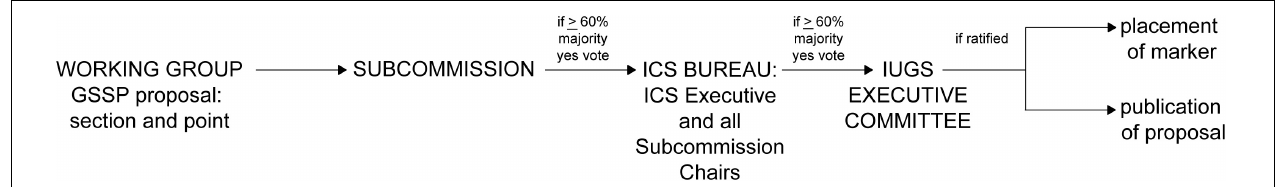
FIGURE 5 | Flow chart showing how the ICS votes on and ratifies a GSSP (redrawn after Finney and Edwards, 2016; used with the permission of the copyright holder, The Lethaia Foundation, Published by John Wiley & Sons Ltd.).